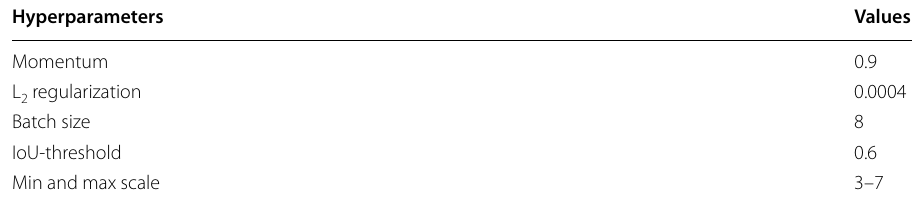
Table 4 Training hyperparameters settings for CNN